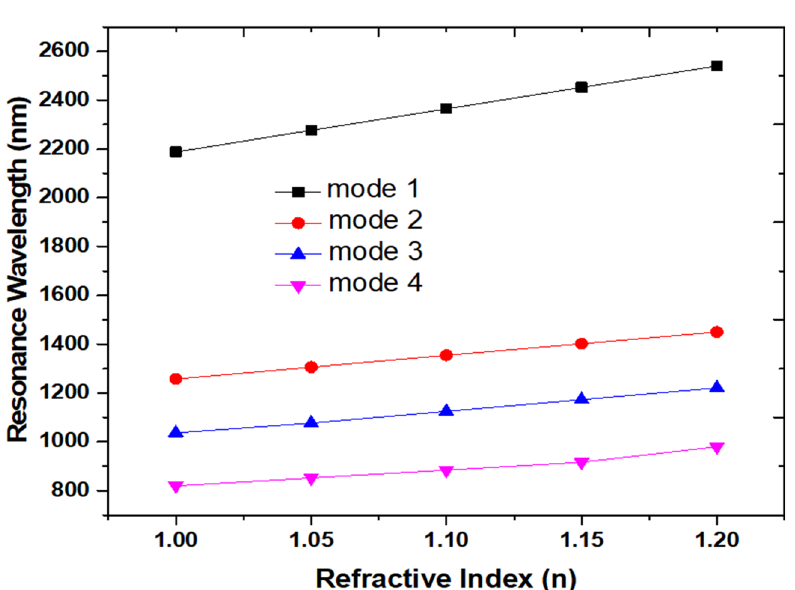
Figure 5. Calculated resonance wavelength (λ res ) from mode 1 to mode 4 of case 2 structure versus the refractive